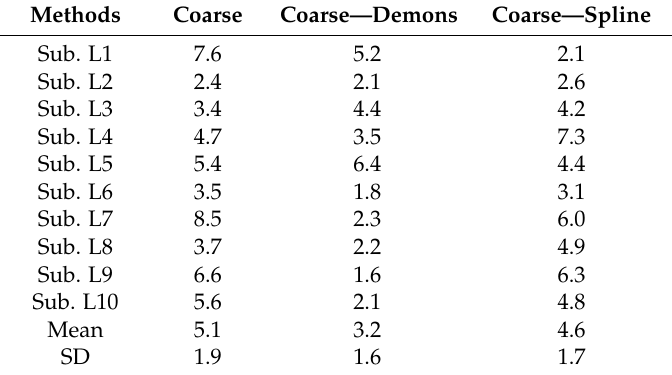
Figure 9. Landmarks as control points for registration accuracy evaluation: ( a ) visible image; ( b ) IR image. Table 2. Registration Matching Error (Landmarks around the eye region as control points), pixels.